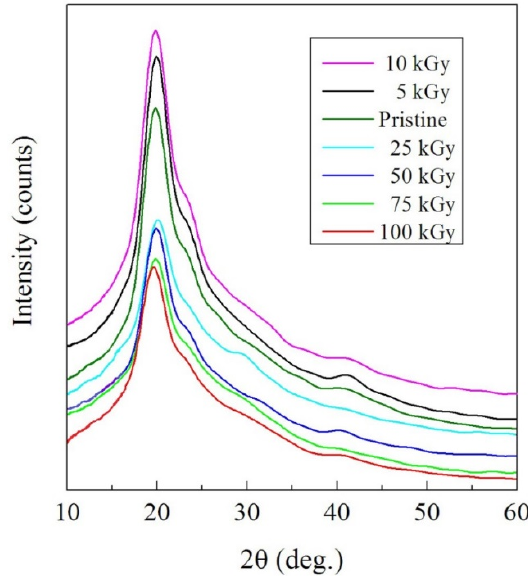
Figure 1. XRD patterns of the irradiated and pristine NC films.